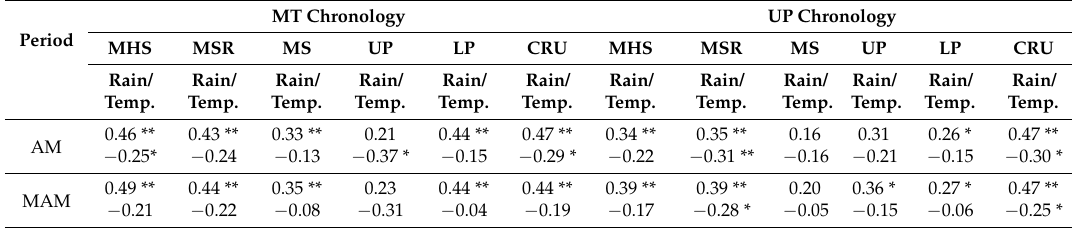
Table 4. Correlation coefficients between tree-ring data and rainfall and temperature.